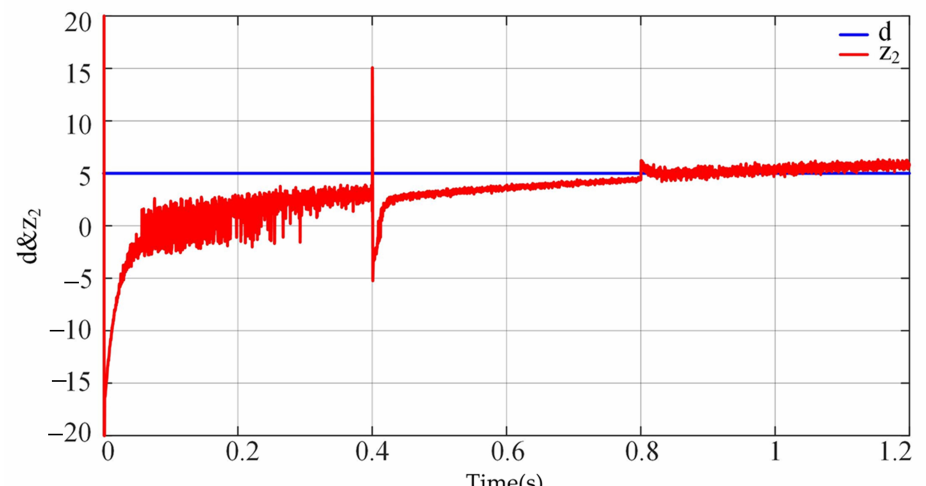
Figure 24. Uncertain disturbance d and predicted disturbance z 2